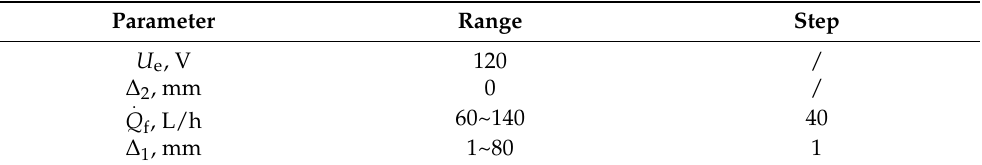
Table 6. Experimental conditions for Factor 4.